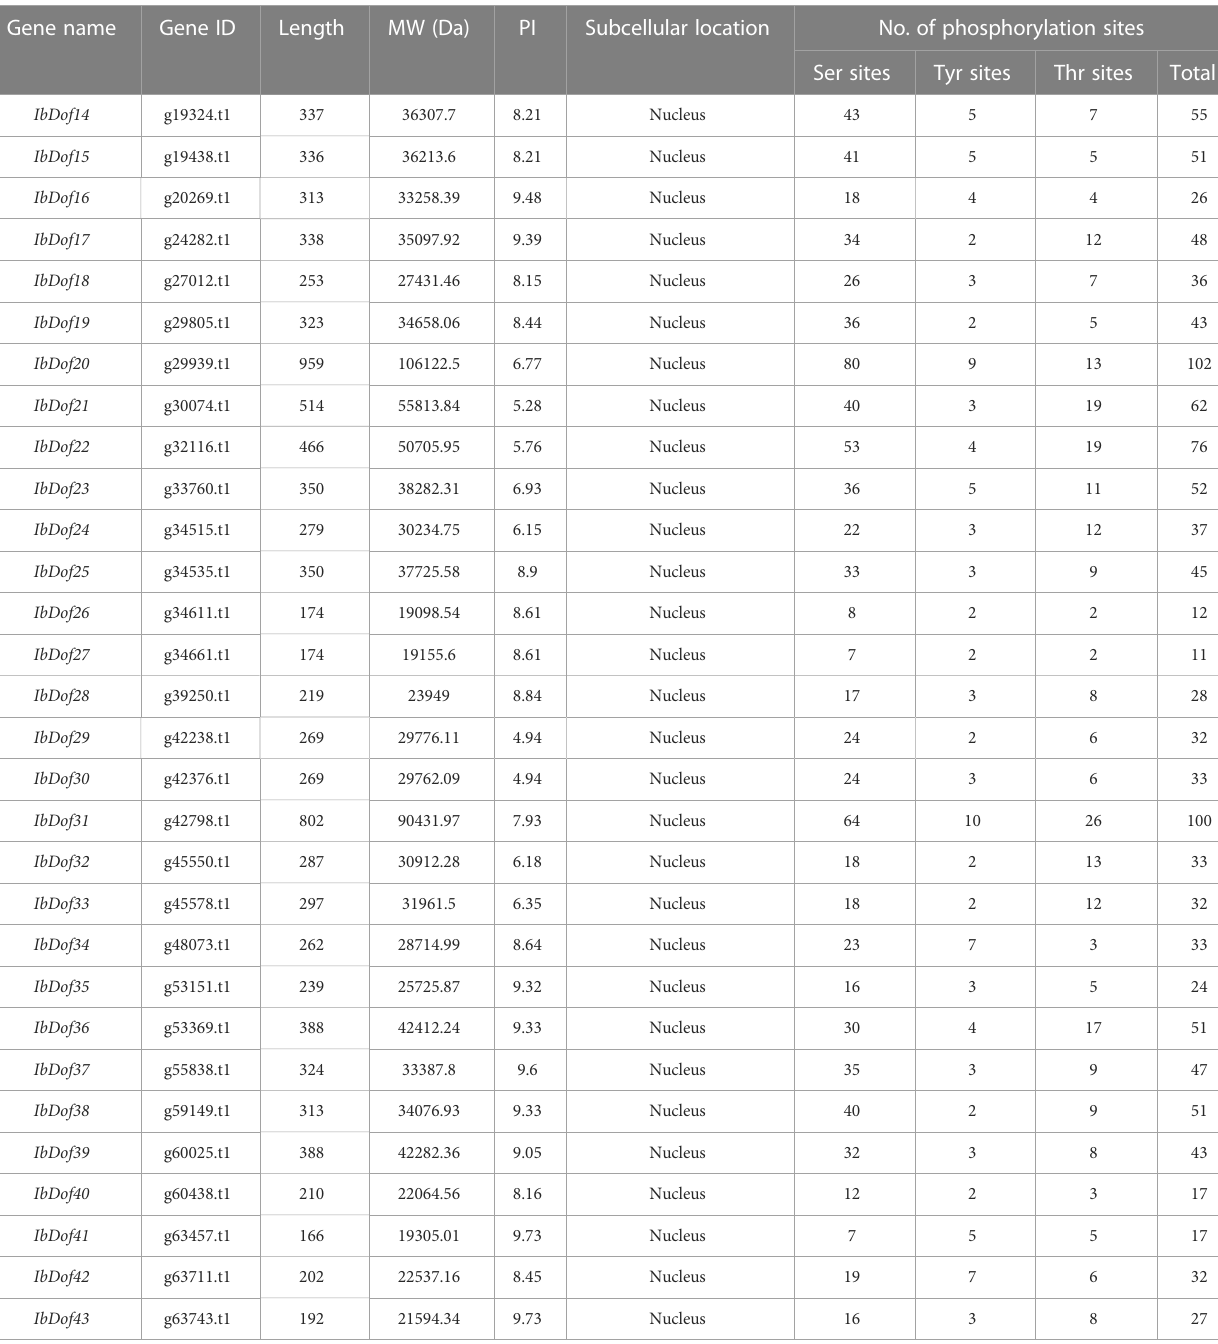
theoretical isoelectric point (pI) of all IbDof proteins were analyzed (Table 1). The amino acid lengths of IbDofs range from 110 (IbDof13) to 959 (IbDof20). As a result, their MW ranges from 12.4 kDa (IbDof13) to 106.1 kDa (IbDof20), while their pI ranges from 4.94 (IbDof29) to 9.73 (IbDof43). The prediction of subcellular localization suggests that all IbDof TFs are localized in the nucleus. Besides, the IbDofs have multiple possible phosphorylation sites, ranging from 11 (IbDof27) to 102 (IbDof20), and roughly 89% of the IbDofs contain at least 20 phosphorylation sites.